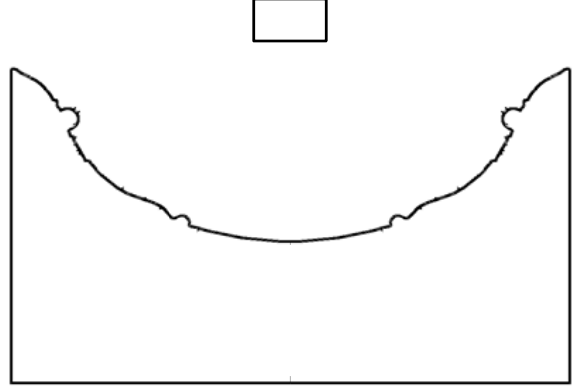
Figure 6. The 2D pit model after fitting.